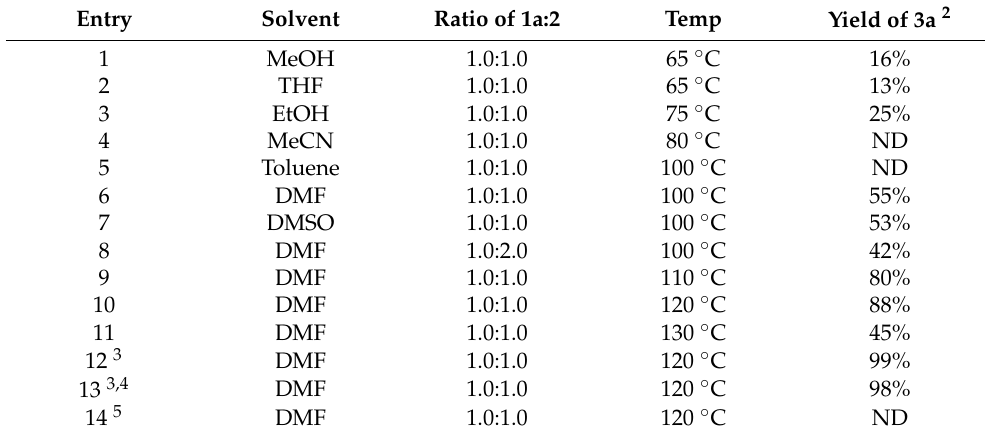
Table 1. Optimization of cyclization reaction 1.